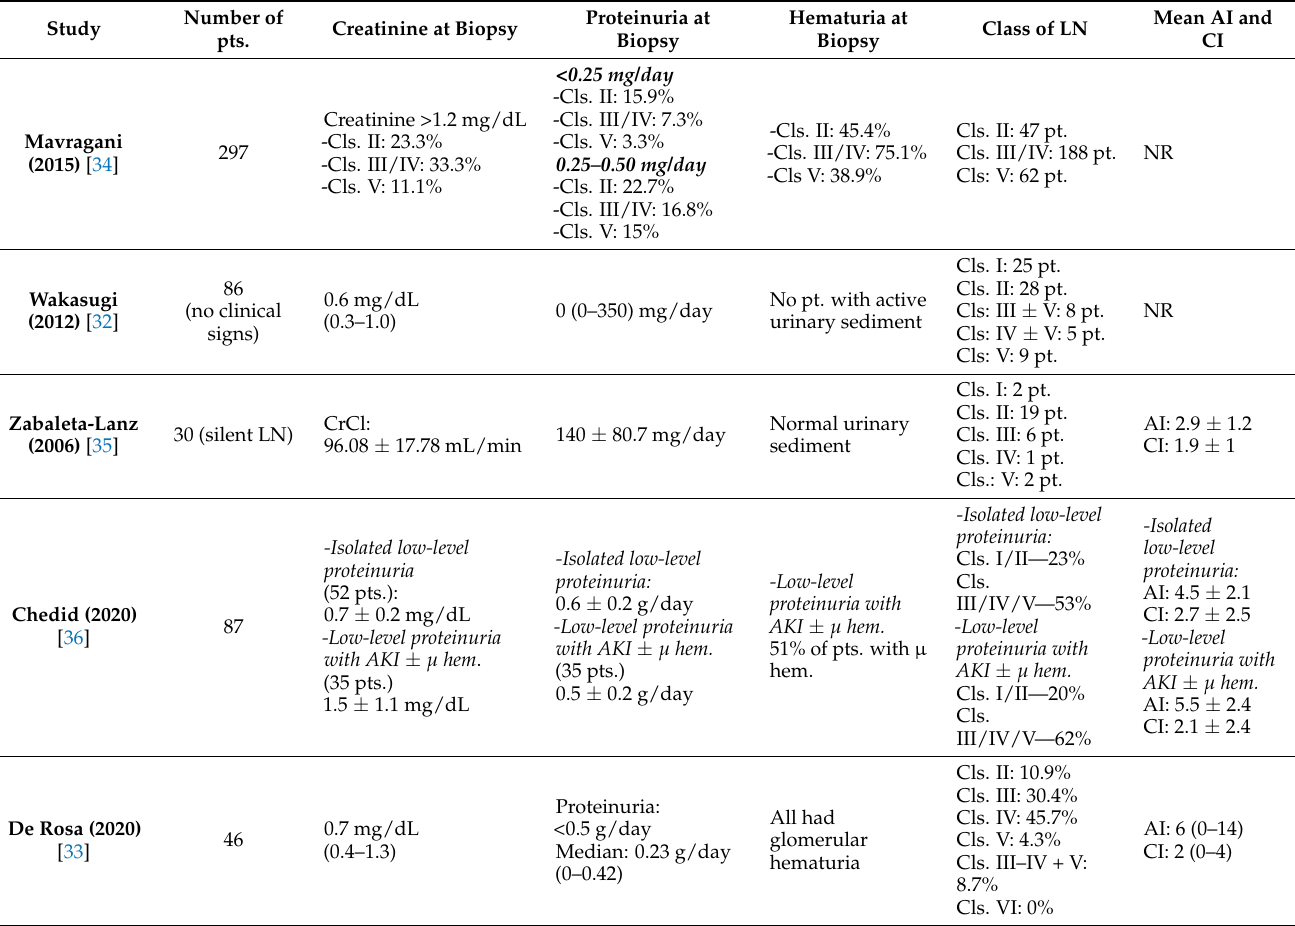
Table 2. Studies evaluating the role of kidney biopsy in patients with low-level